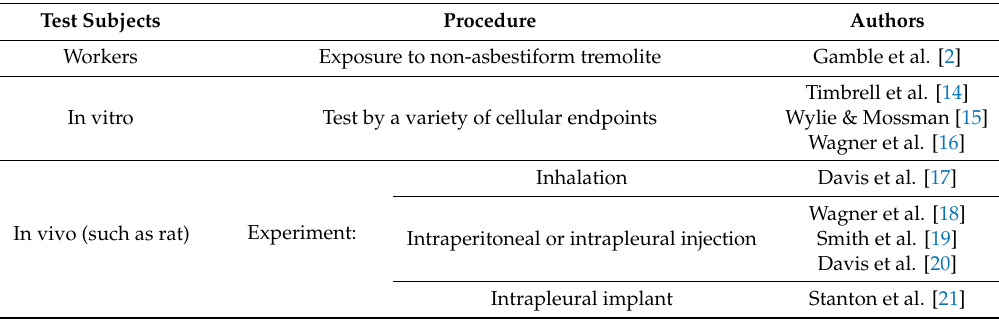
Table 1. Carcinogenic experiment on asbestiform and non-asbestiform